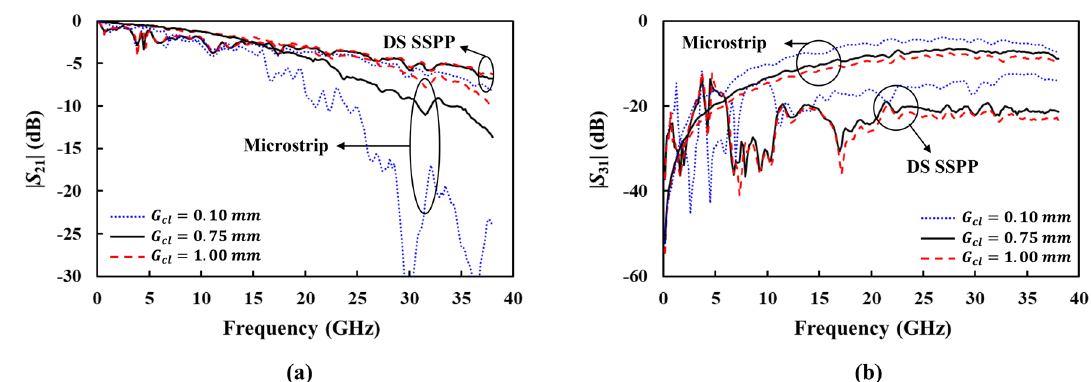
Figure 10. Measured results of microstrip and DS SSPP coupled lines for G cl = 0.10 (dotted), 0.75 (solid), and 1.00 mm (slotted). ( a ) | S 21 | . ( b ) | S 31 |